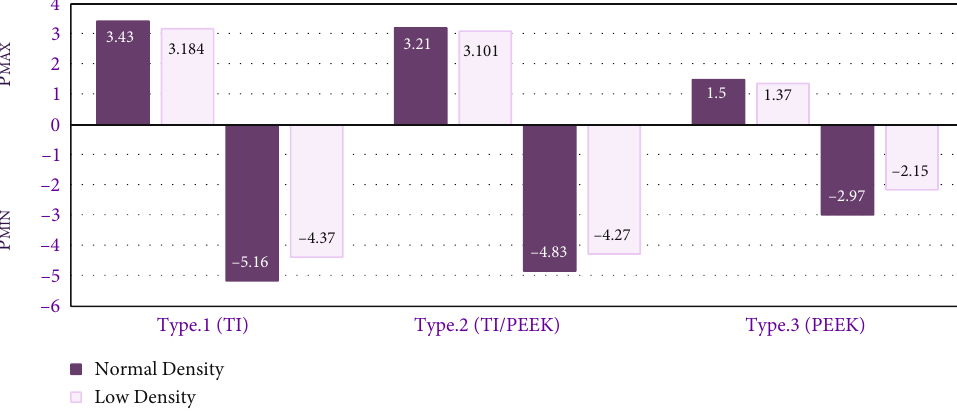
Figure 8: Maximum and minimum principal strains ( με ) on cortical